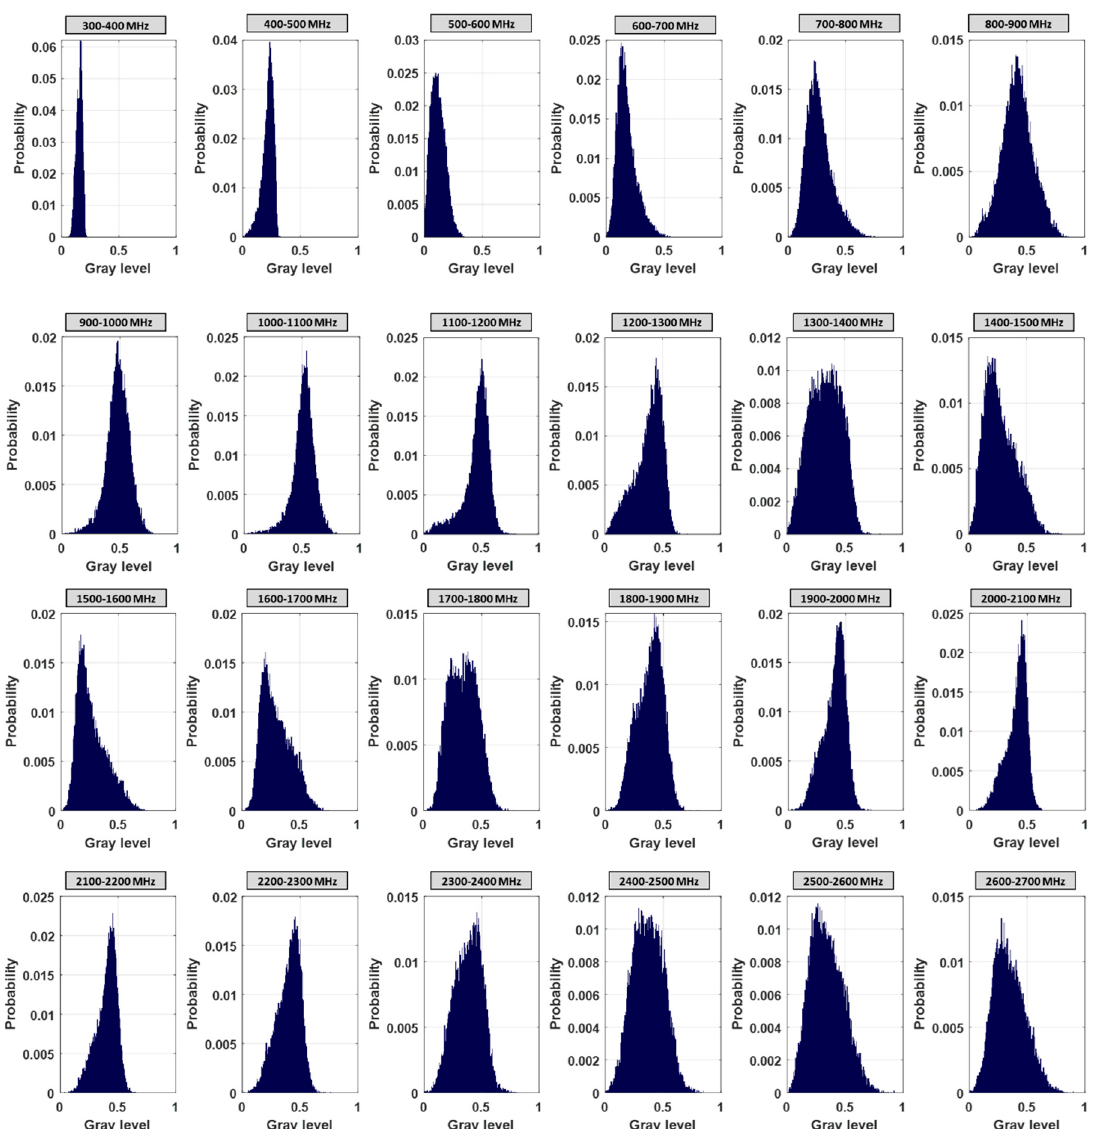
Figure 14. Histograms of the obtained GPR slice depending on the frequency interval.